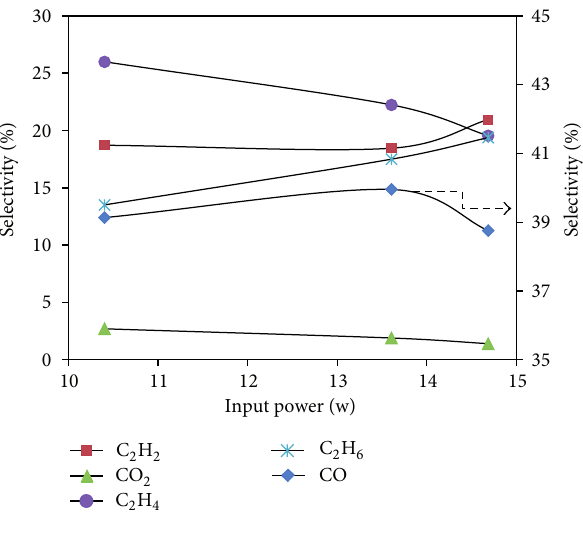
F 7: Selectivity of products versus power applied to the reactor over Fe-ZSM5 catalyst in plasma environment.